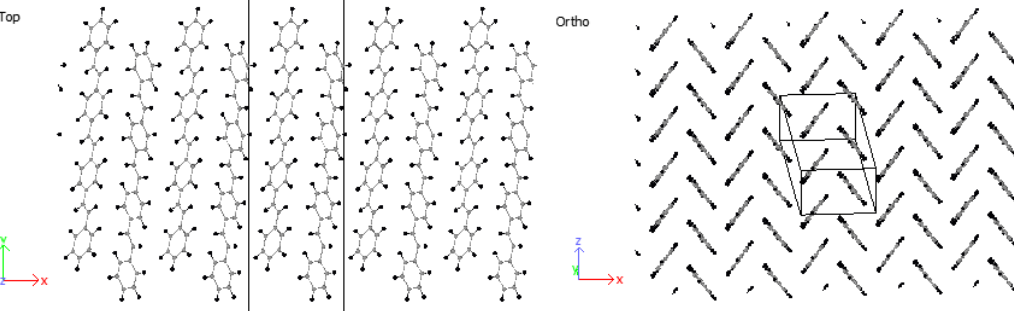
Figure 13. Four-PPV oligomer chains (4PPV) HB-packing from simulation.